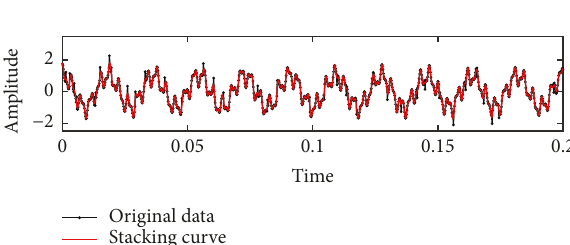
Figure 9: Relevant spectra figures by EMD.